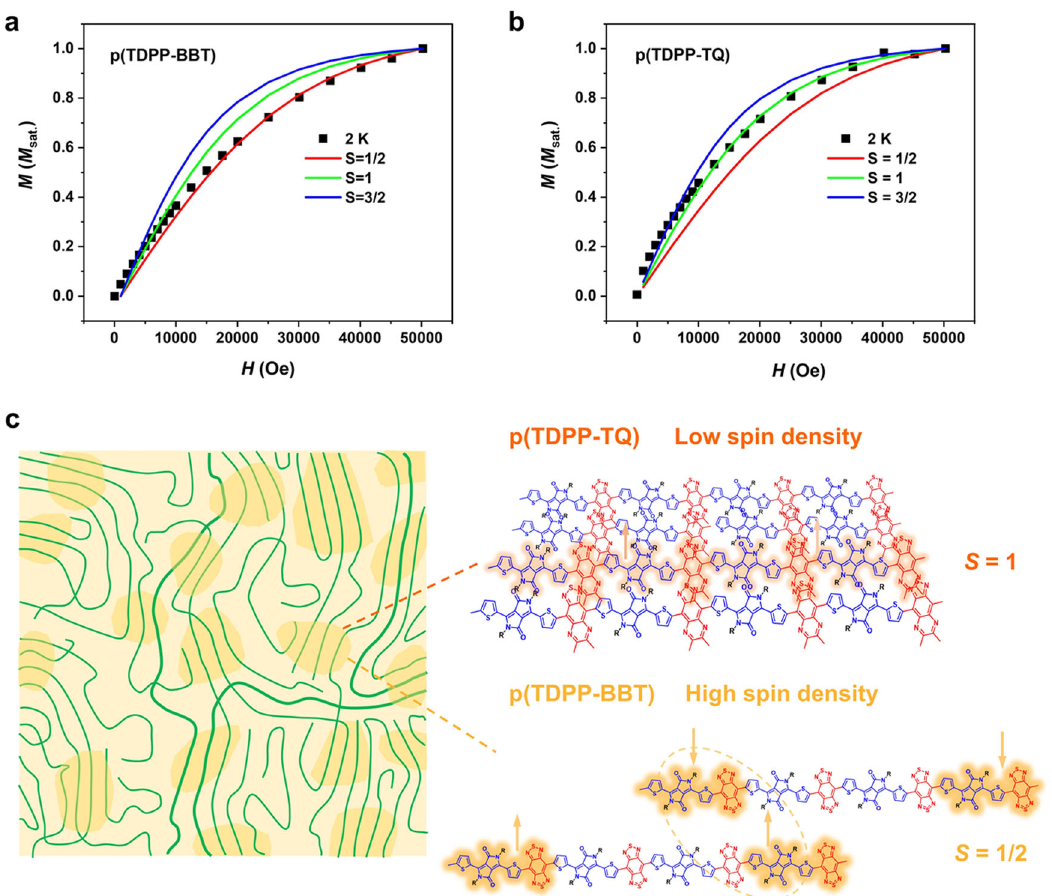
Fig. 5 Magnetic characterization and the mechanism explanation of the different spin ground states of high-spin polymers. Field dependent magnetization measurement of a p(TDPP-TQ) and b p(TDPP-BBT) from 0 Oe to 50,000Oe. The solid squares are the experimental data, the solid lines stand for the simulated curve by Brillouin equation. The simulation results exhibit the S = 1 and S = 1/2 ground states of p(TDPP-TQ) and p(TDPP-BBT). c Schematic illustration of the mechanism of the different ground states of p(TDPP-TQ) and p(TDPP-BBT). Left image shows the microstructure of a typical polymer fi lm, which contains ordered crystalline regions (highlighted in darker yellow) and amorphous regions. Right image illustrates the spin-spin interactions in solid state. The orange shadings on the polymers indicate where the spins mostly distribute. In p(TDPP-TQ), the low spin density makes the spins mostly interact within a chain. While in p(TDPP-BBT), we observed interchain spin-spin interactions because of its high spin